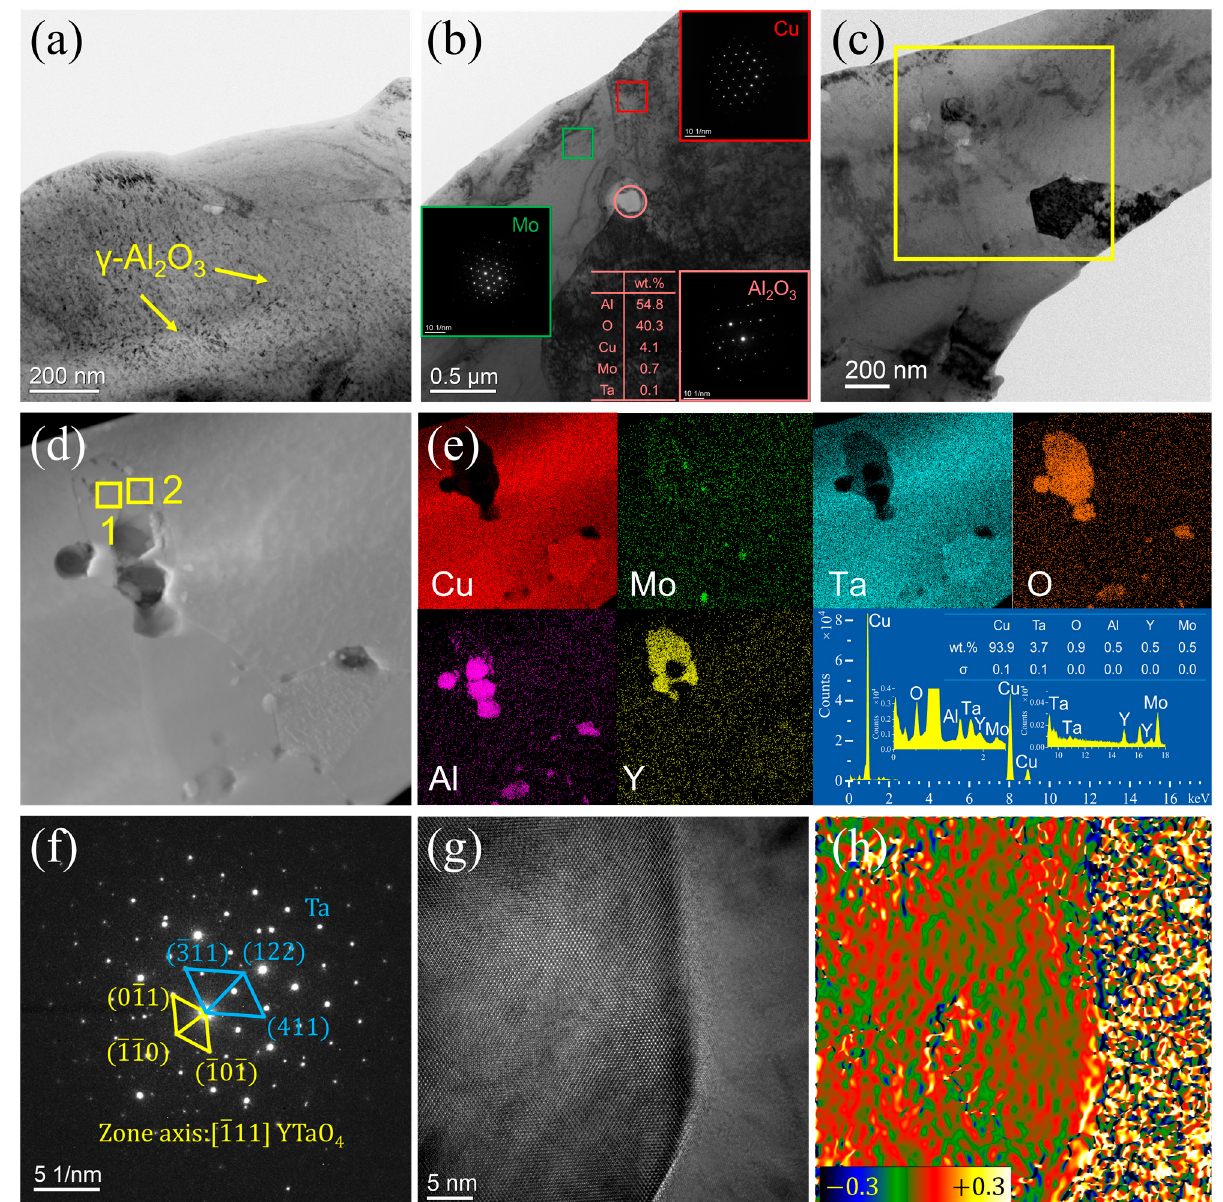
Figure 7. TEM images of 0.5Y 2 O 3 /Al 2 O 3 -Cu/25Mo5Ta composites: ( a – c ) Bright-field TEM images of composites; ( d ) Dark-field phase of ( c ); ( e ) EDS images of ( d ); ( f ) SADP of region 1 in ( d ); ( g ) HRTEM images of region 2 in ( d ); ( h ) GPA of ( g ).